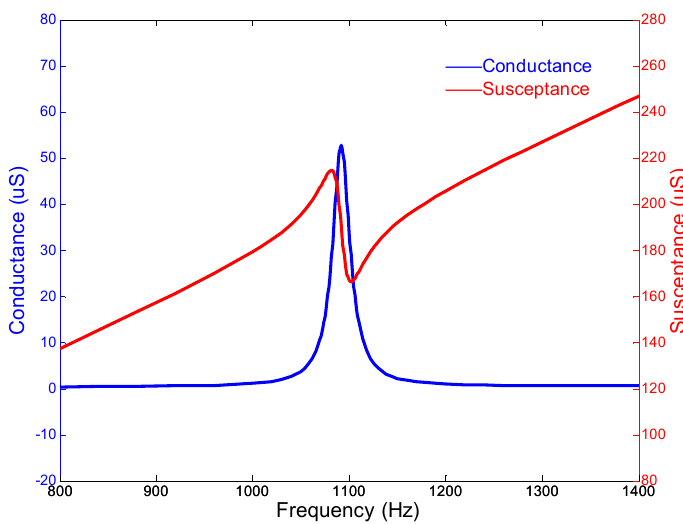
Figure 7. Admittance curves of the cascade-connected transducer with ten segments.